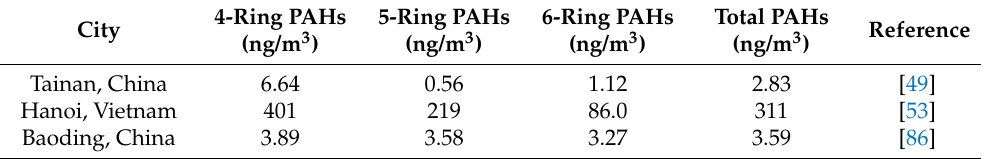
Table 6. Composition of the PAHs in different studies in normal period and biomass burning period.